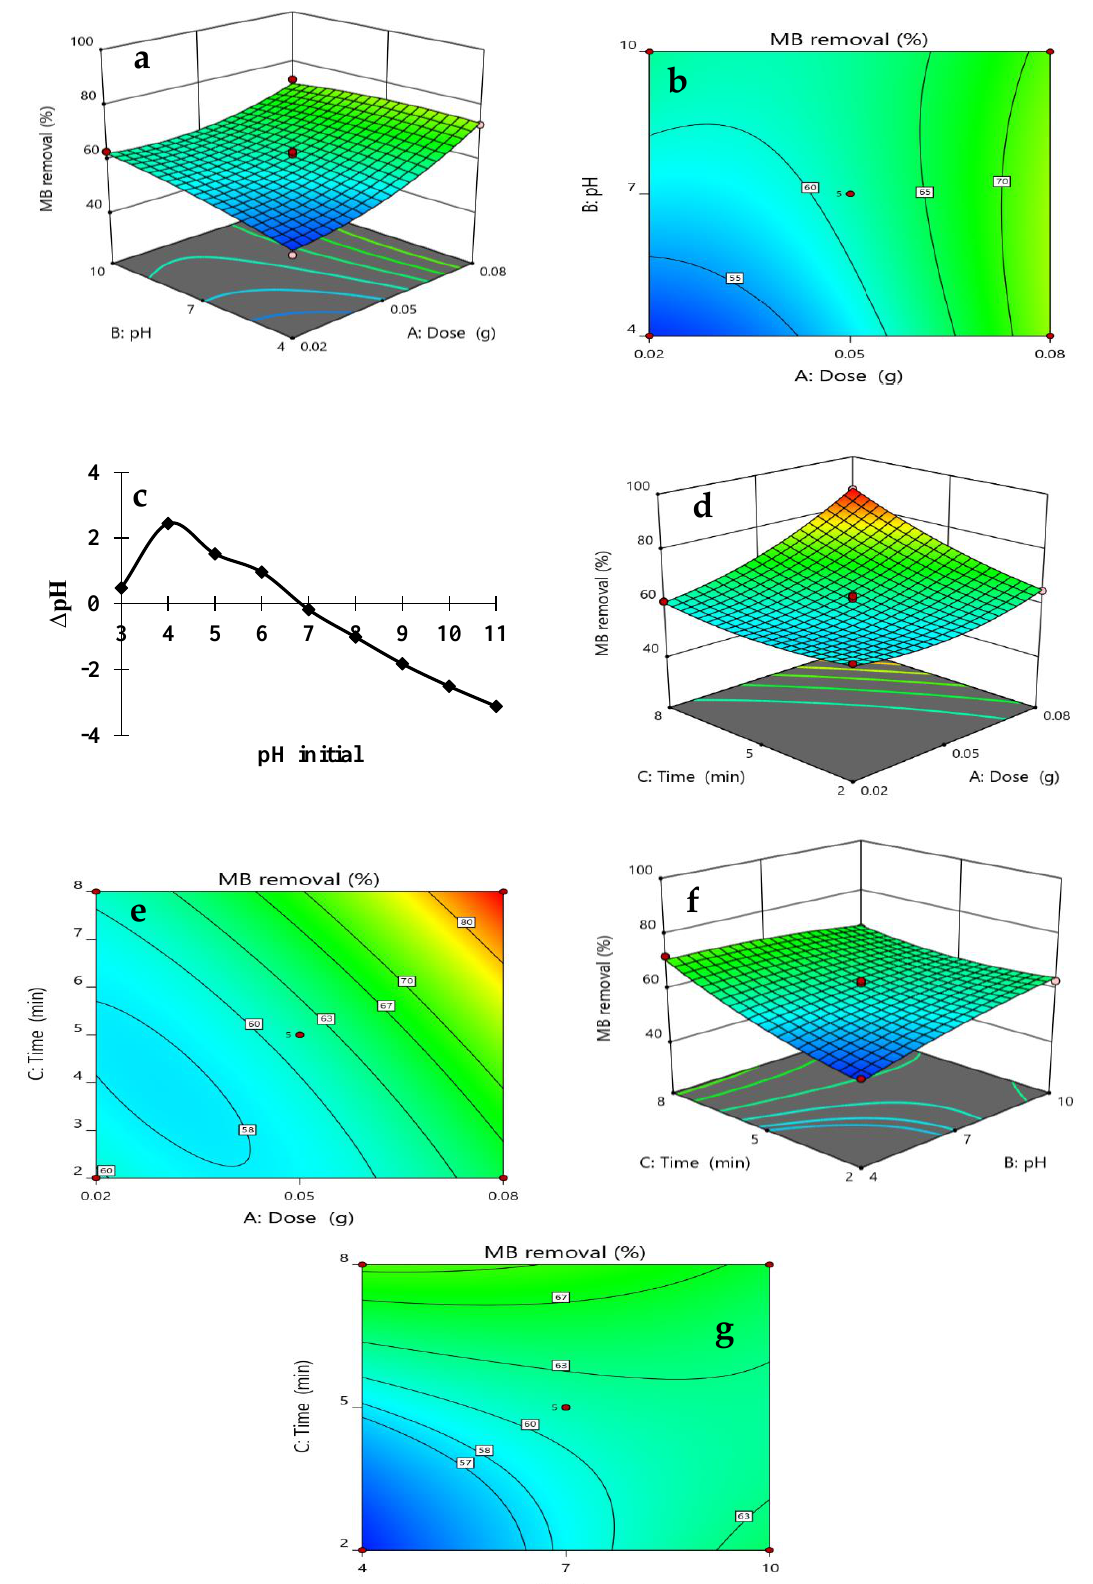
Figure 5. Three-dimensional response surface plot and contour plots showing the interactions between ( a , b ) dose and pH, ( c ) pHpzc of BWAC, ( d , e ) dose and time, and ( f , g ) pH and time for MB removal by BWAC.